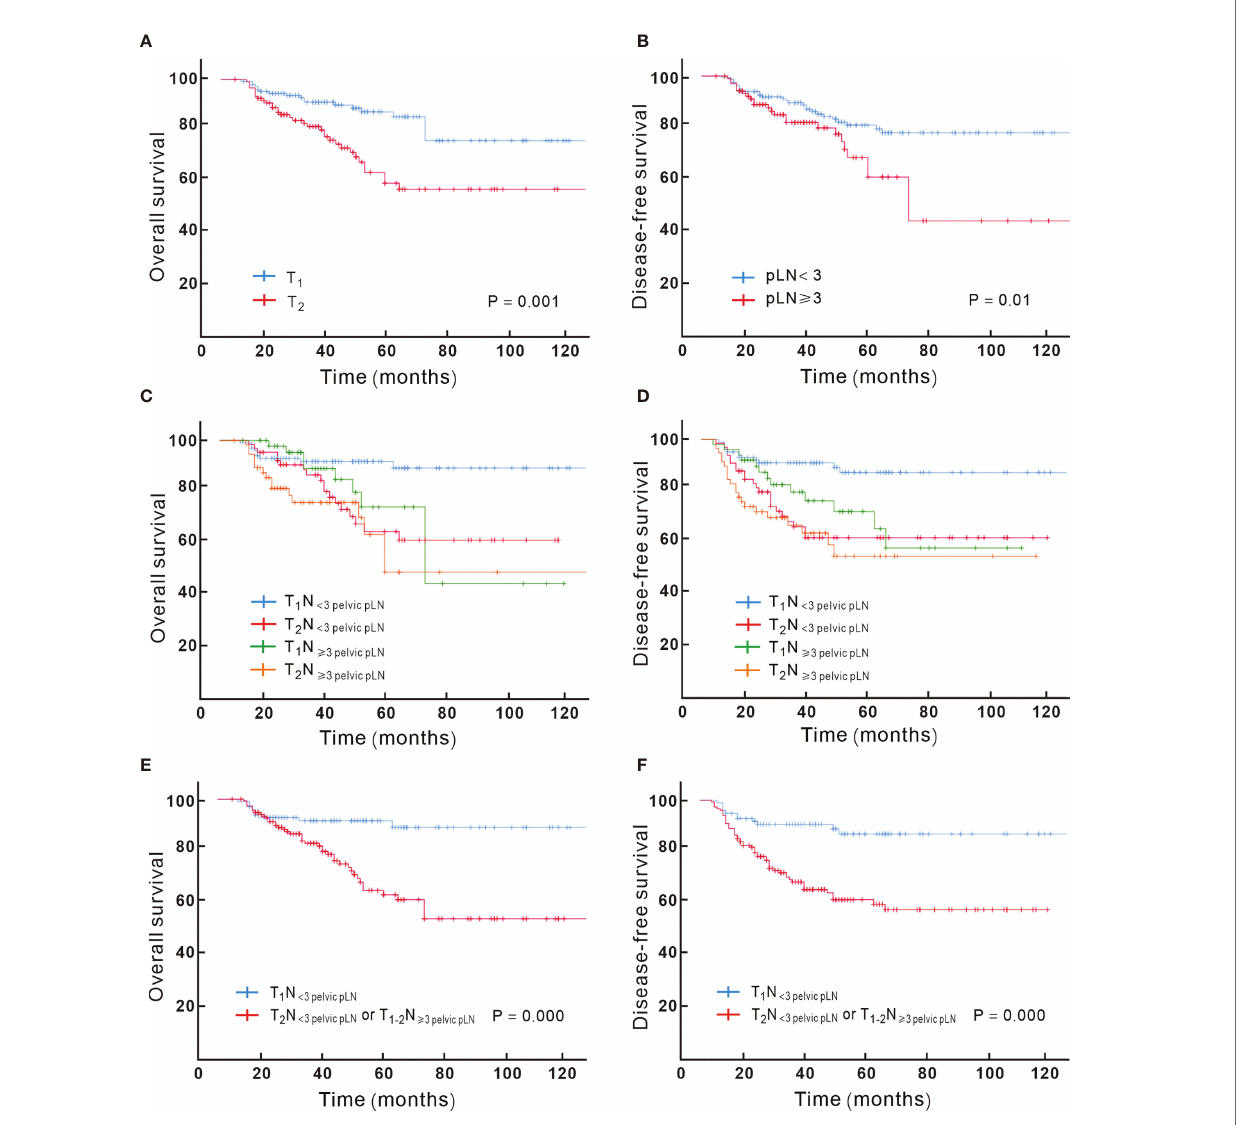
FIGURE 2 | Kaplan – Meier analysis of overall survival for patients showed signi fi cant difference when strati fi ed by T-stage (A) and the number of pathologic lymph node (B) ; the overall survival and disease-free survival based on different combination of T and N substage are showed in (C, D) , with T 1 N < 3 pelvic pLN showing signi fi cant better overall (E) and disease-free survival (F) compared to T 2 N < 3 pelvic pLN or T 1-2 N ≥ 3 pelvic pLN